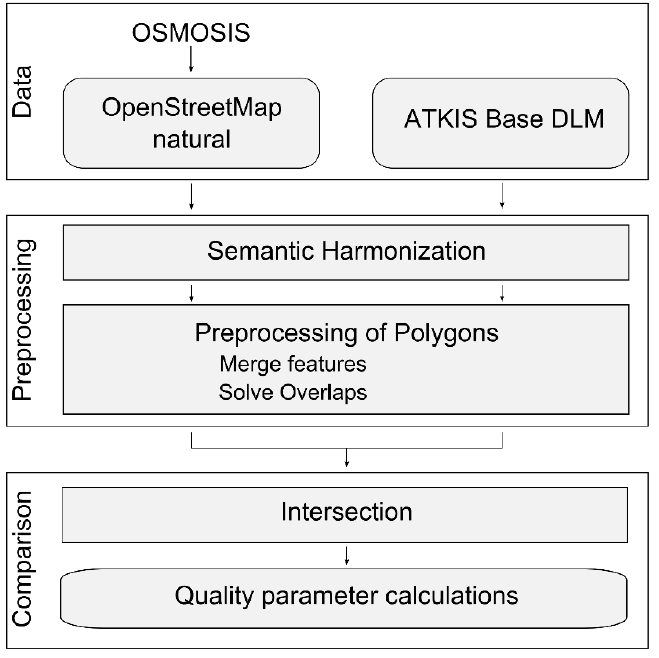
Figure 2. Workflow for the comparison between OSM and ATKIS Base